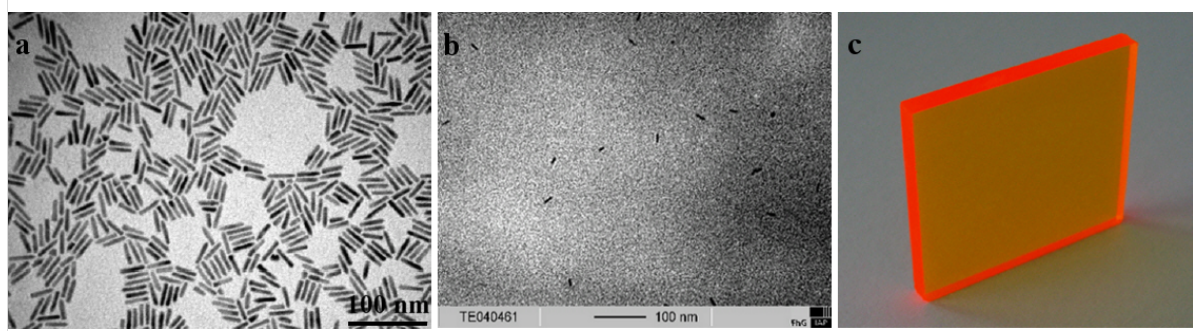
containing 0.05 wt % aspect ratio 6 NRs is shown in Figure